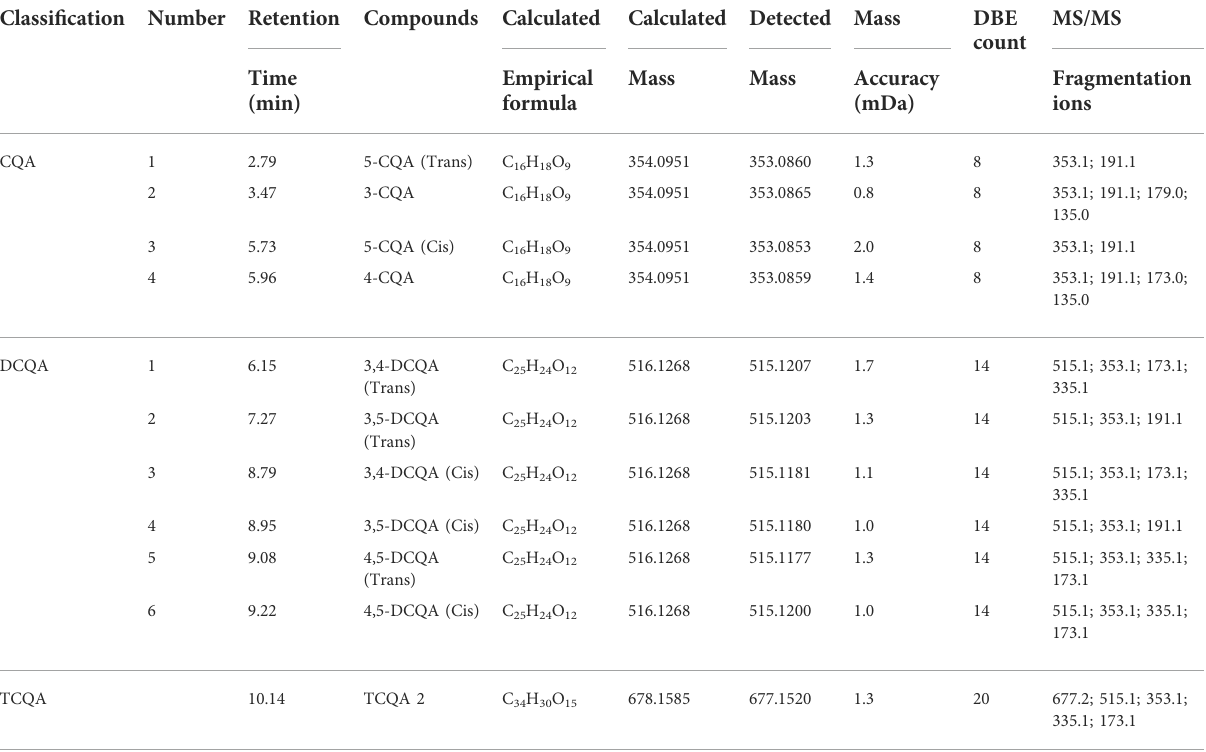
TABLE 3 Chlorogenic acids composition of H. aureonitens